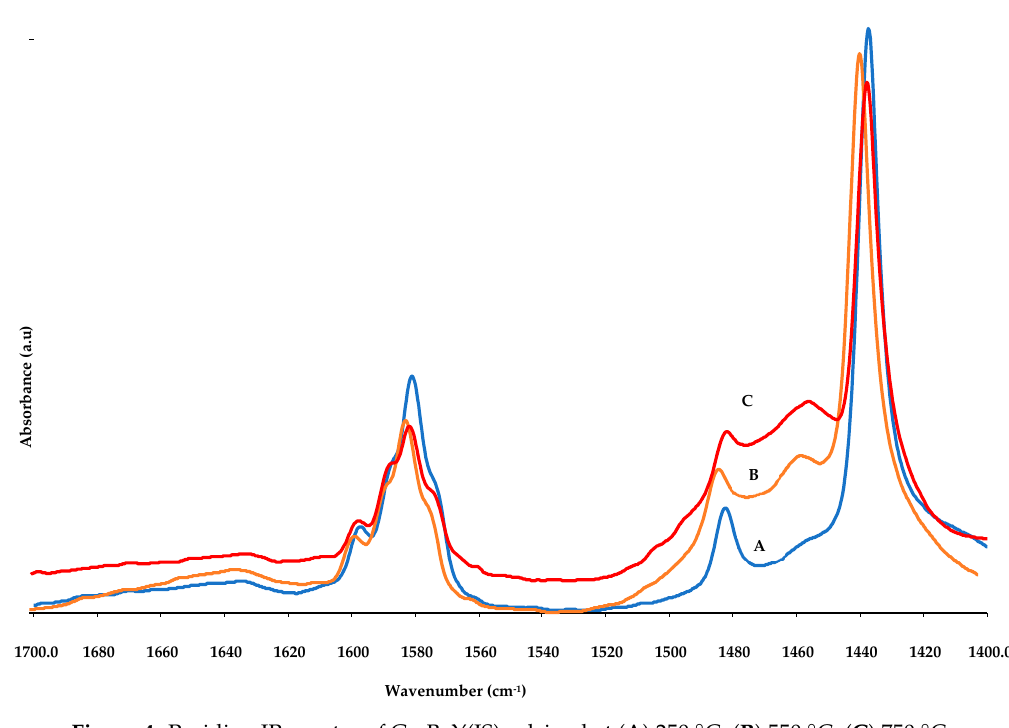
Figure 4. Pyridine-IR spectra of Ga-BaY(IS) calcined at ( A ) 250 °C, ( B ) 550 °C, ( C ) 750 °C.